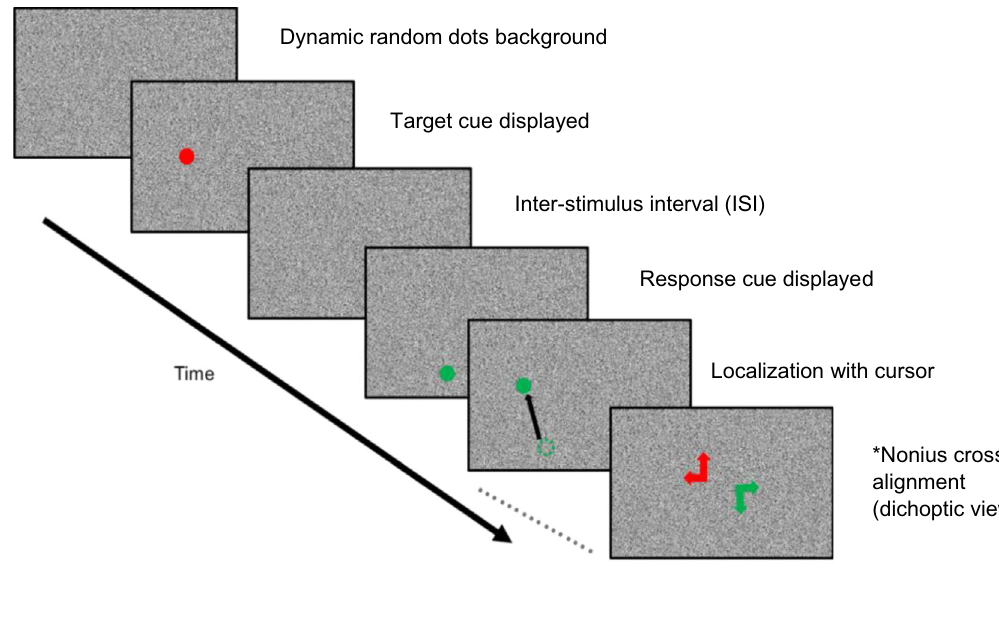
Figure 1. Sequence of events for a trial (monocular or dichoptic paradigm). Two 1.5° diameter circles (red— target cue; and green—response cue) were displayed in sequence, on a random dot background, with a variable inter-stimulus interval (ISI = 0.25, 0.5, 1, 1.5, 2, 5, and 7 s). Subjects then used a mouse cursor (black arrow; not visible during the trial) to mark the remembered location of the target cue. Red and green nonius lines